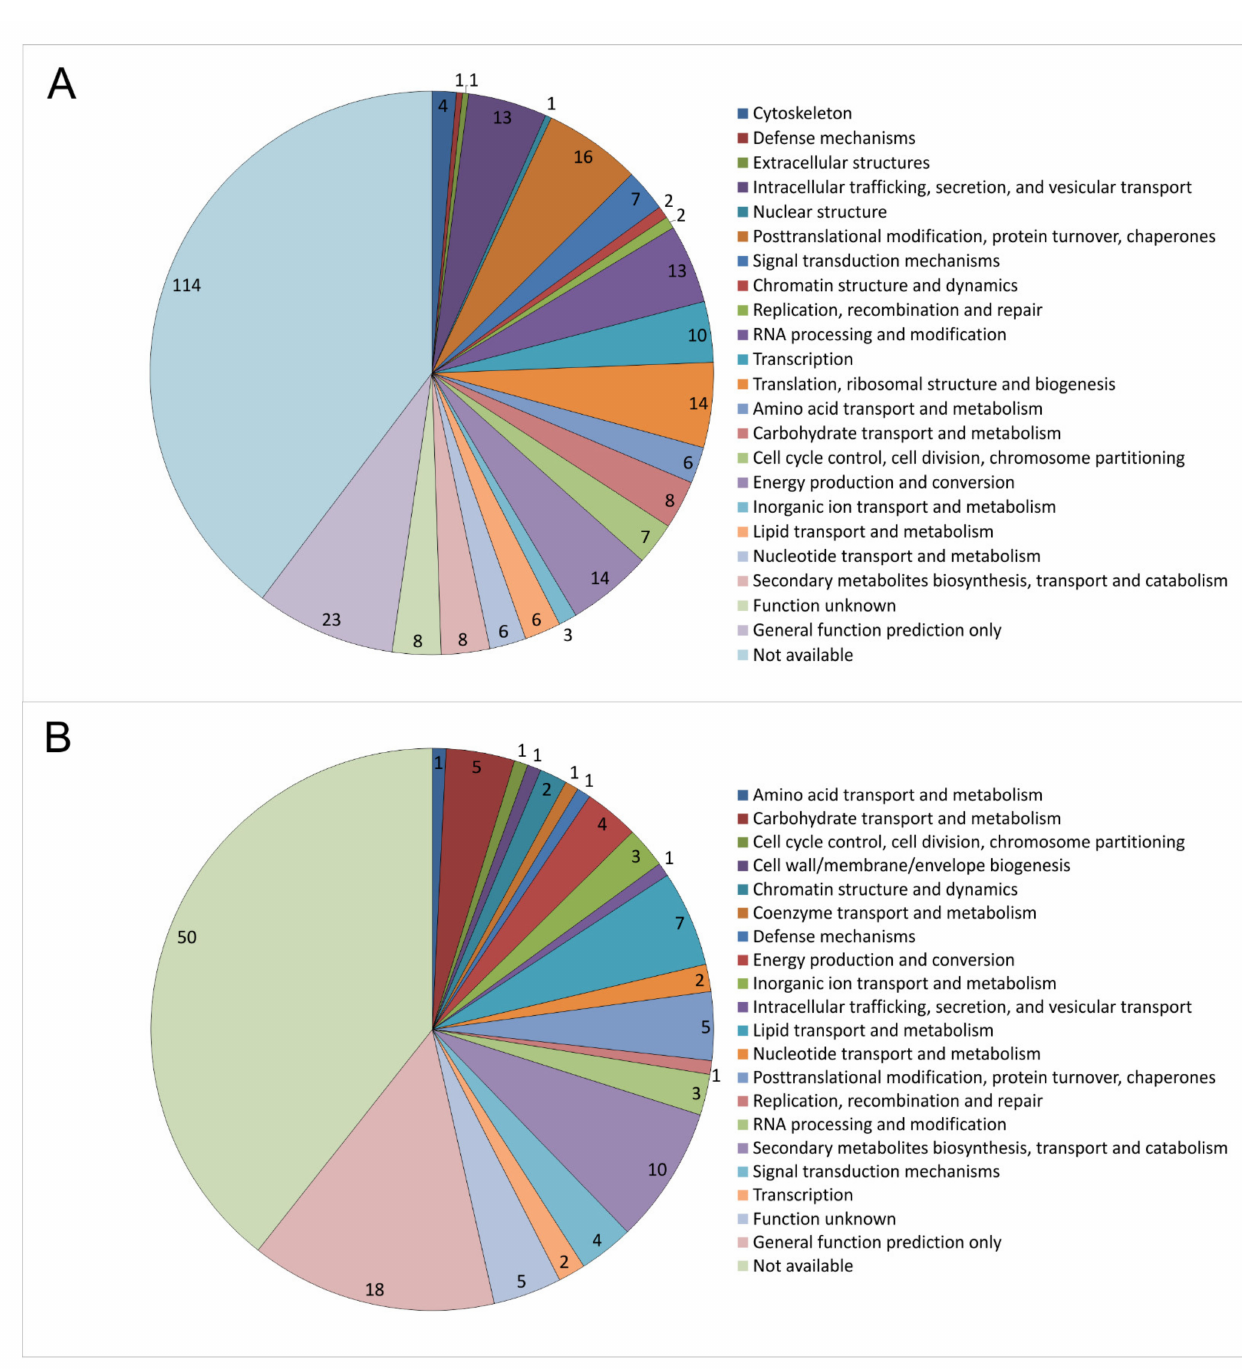
Figure 6. Membrane-associated proteins regulated with respect to imp1 overexpression in S. commune OEIMP4 versus empty vector control S. commune EVC1. KOG classification of 287 induced ( A ) and 127 repressed proteins ( B ) are